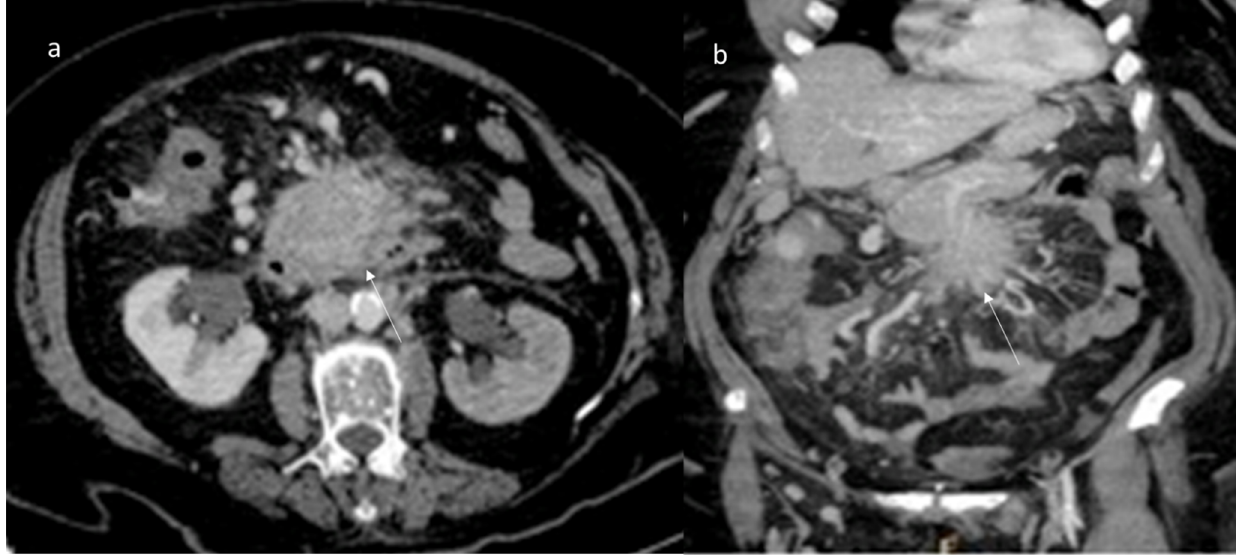
Figure 3. Axial ( a ) and MPR coronal ( b ) CT assessment of aggressive fibromatosis (arrow) in portal phase of contrast study. The lesion shows mild enhancement and involvement of blood vessels.